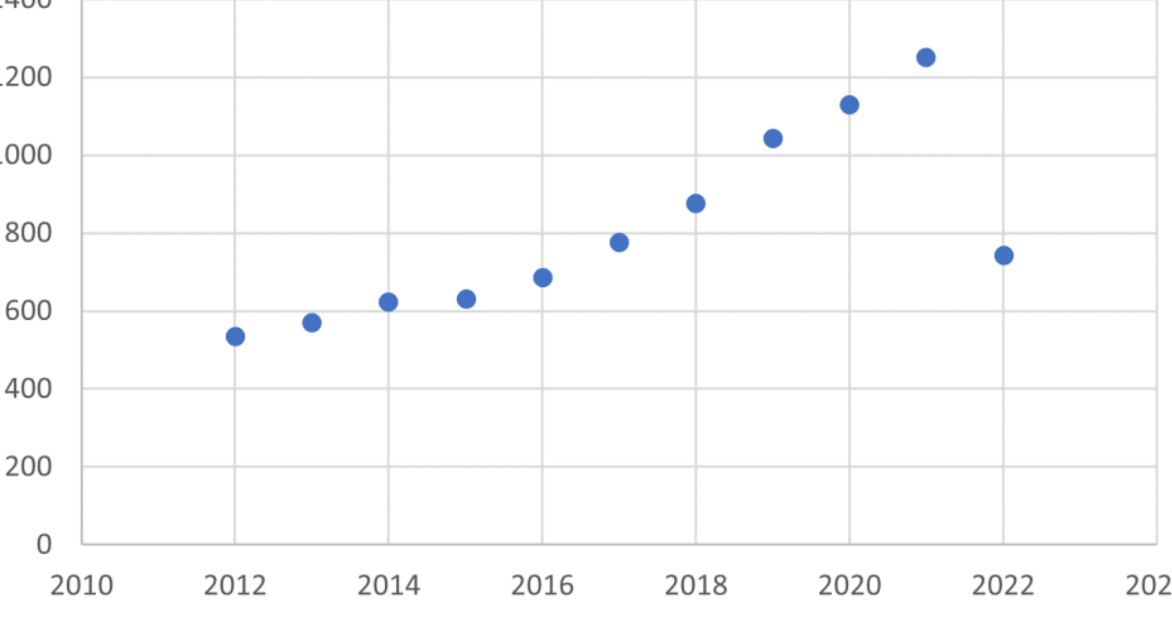
Figure 5. Number of publications on BIM technology.